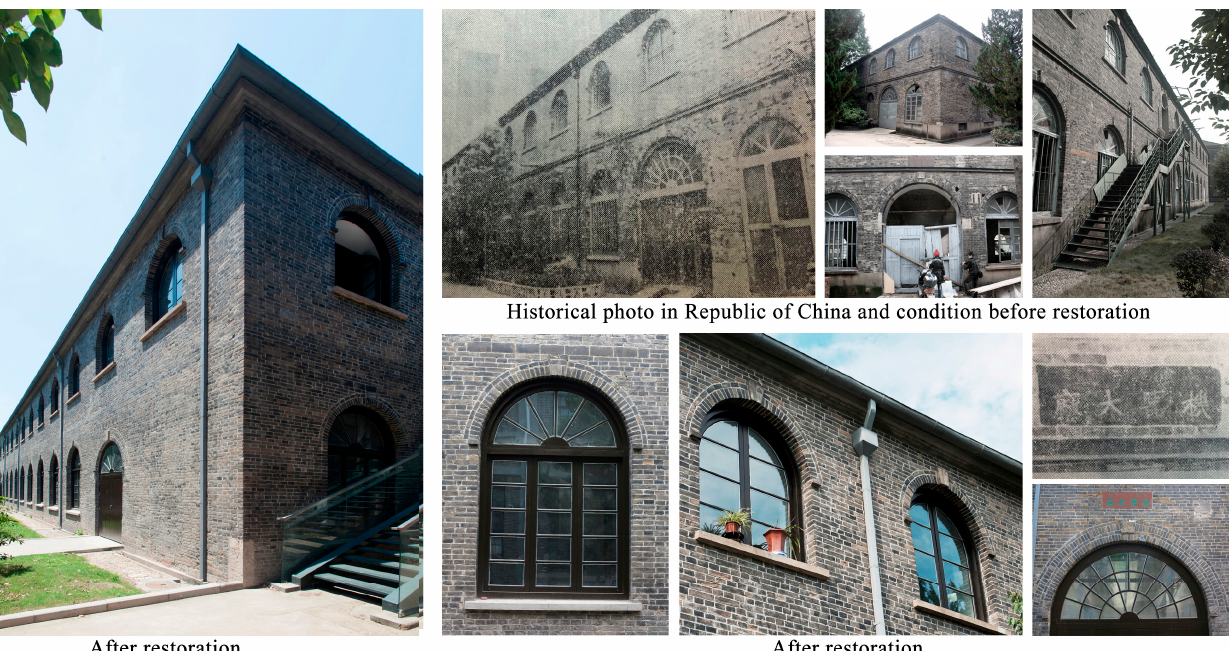
Figure 16. Facade comparison before and after restoration. Pictures by X.X.